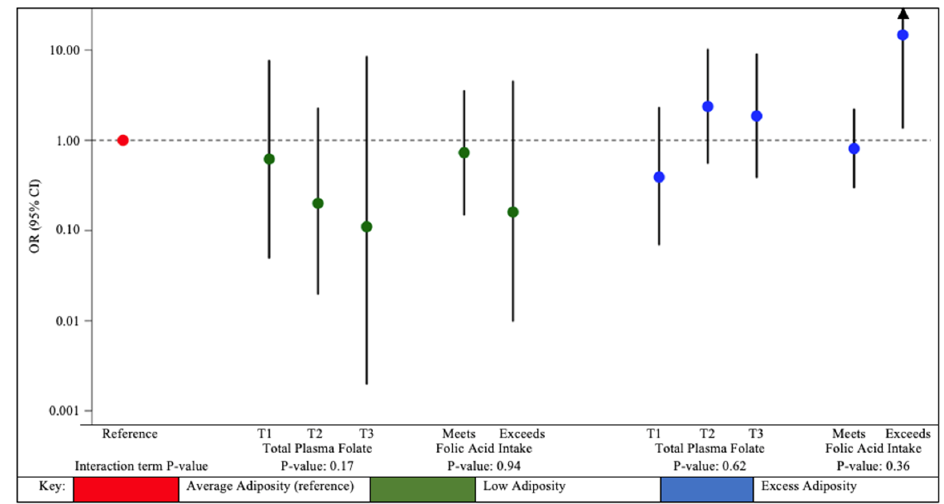
Figure 4. Adjusted odds ratios of anthropometric phenotypic profile membership with 10-fold in- crease in maternal first trimester urinary DMA concentrations, stratified by terciles of total plasma folate and categories of folic acid intake from supplements among MIREC study